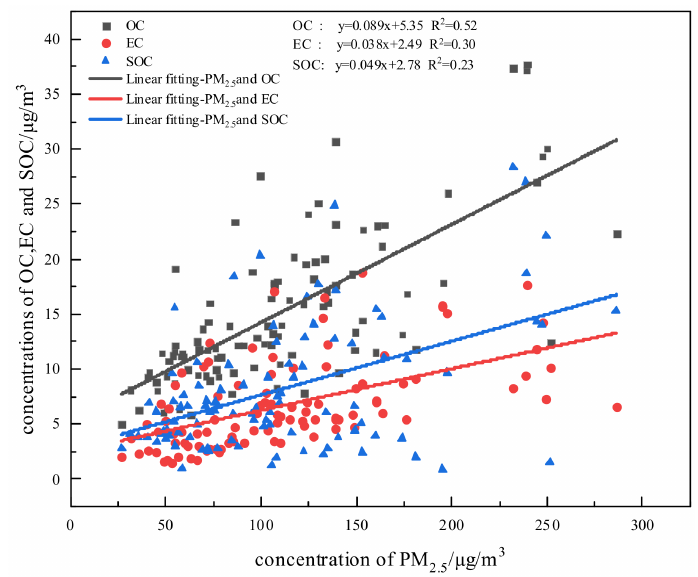
Figure 5. Correlation between PM 2.5 with OC, EC and